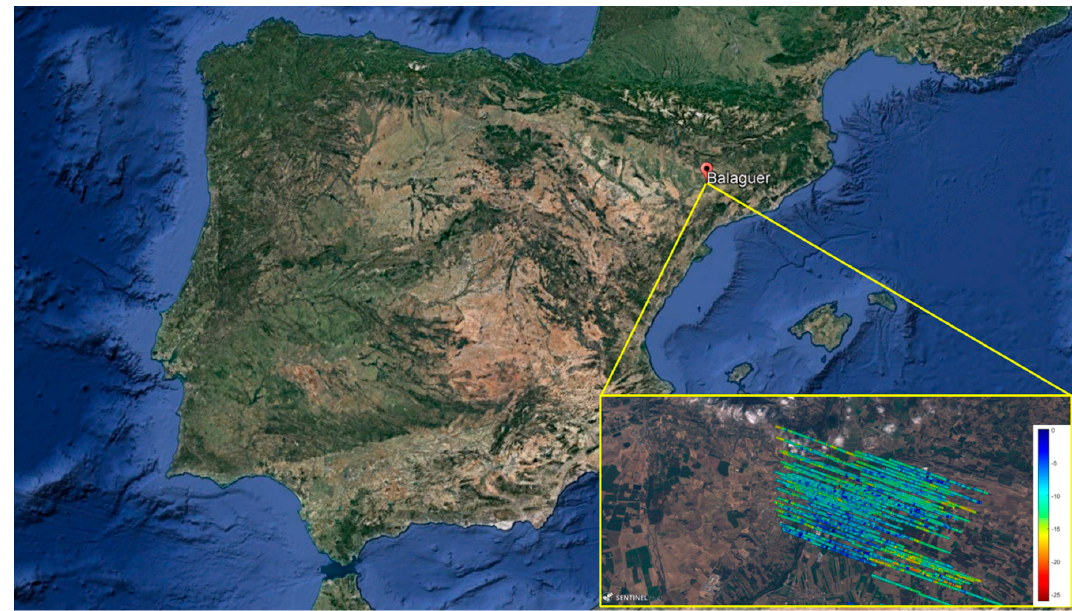
Figure 3. Location of the experiment area in the north east of the Iberian peninsula, near Balaguer (41.9 ° N, 0.80 ° E), Lleida, Spain. Zoom shows the collected GNSS-R data strips in [dB].